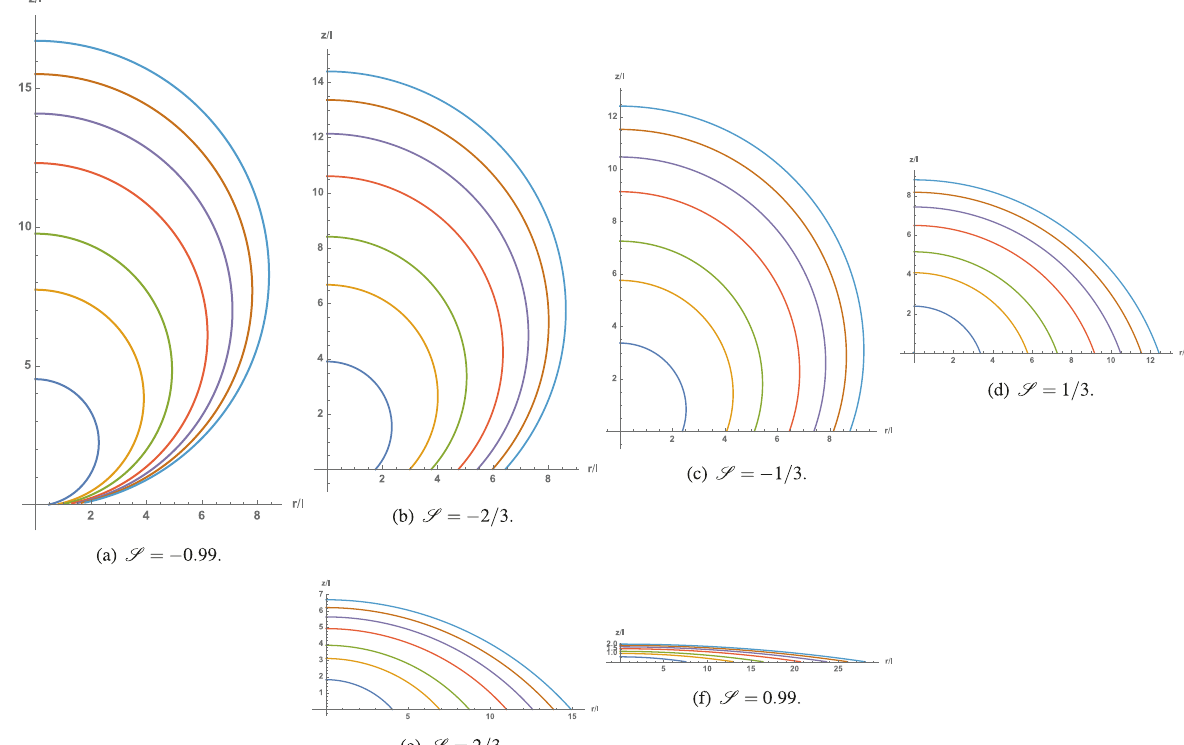
Fig. 5 In fl uence of sessile drop volume on its shape in the small to medium range. V ¼ 5 (dark blue), 25 (brown), 50 (purple), 100 (orange), 150 (green), 200 (yellow) and 250 (light blue), for six values of S and negative S = l σ . a S ¼ (cid:1) 0 : 99 ; ( b ) S ¼ (cid:1) 2 = 3 ; ( c ) S ¼ (cid:1) 1 = 3 ; ( d ) S ¼ 1 = 3 ; ( e ) S ¼ 2 = 3 ; ( f ) S ¼ 0 : 99